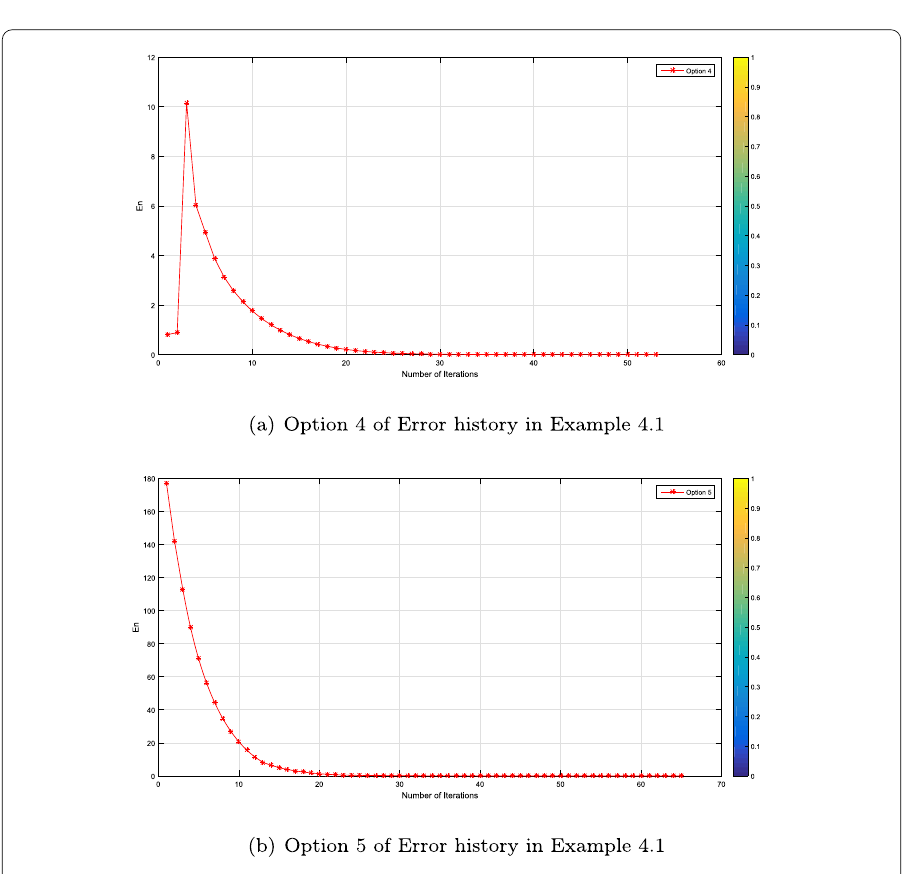
Figure 1 Error history in Example